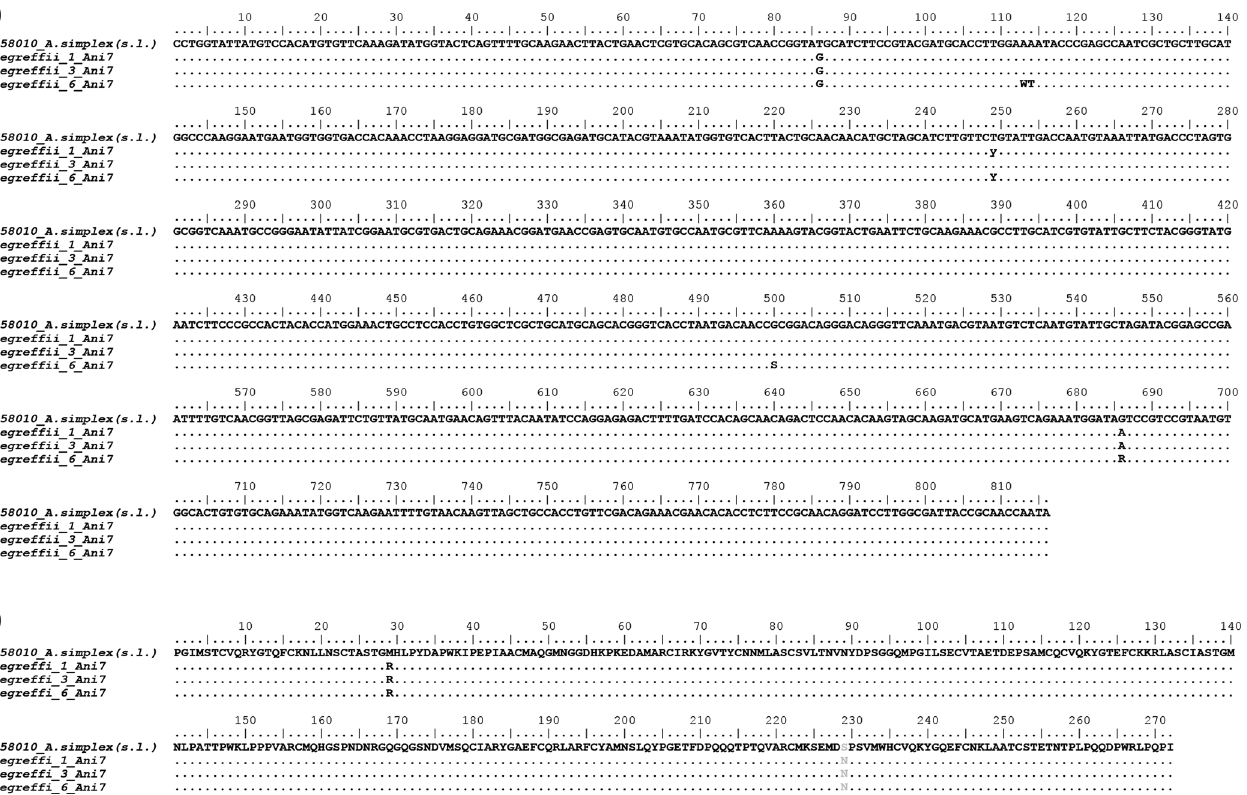
Figure 2. Nucleotide and amino acid sequence alignment of A.peg-7 cDNA. (a) Nucleotide sequence alignment obtained from A. pegref fi i larvae from the present study with respect to the internal Ani s 7 cDNA (nucleotide [nt] 1203 – 2139) fragment [a potential antigenic region] of those previously deposited in GenBank as A. simplex (s. l.) (Accession No.: EF158010). Dots indicate identity with the consensus sequence. (b) Amino acid sequence alignment of the deduced amino acid sequences of the A.peg-7 allergen showing the variable sites between A. pegref fi i, and previously reported A. simplex (s. l.). Dots represent residues identical to the reference Ani s 7